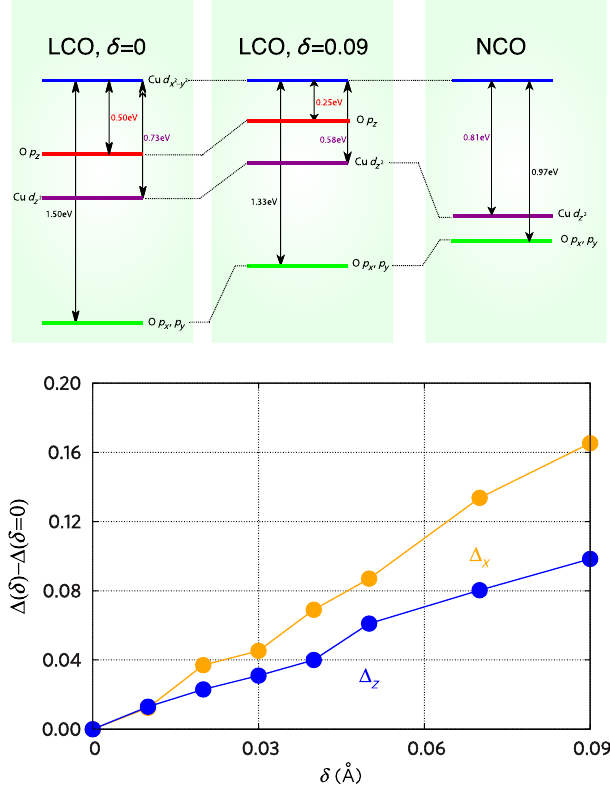
FIG. 3. Energy levels and charge transfer energy. Upper panel: The relative positions of the relevant QS GW orbitals for δ ¼ 0 , 0.09 Å and NCO. Lower panel: Variation upon apex displacement of the in-plane charge transfer energy Δ x ¼ ϵ − ϵ and of the out-of-plane Cu-AO charge transfer p x d x 2 − y 2 − ϵ energy Δ z ¼ ϵ p . d z 3 z 2 − r 2